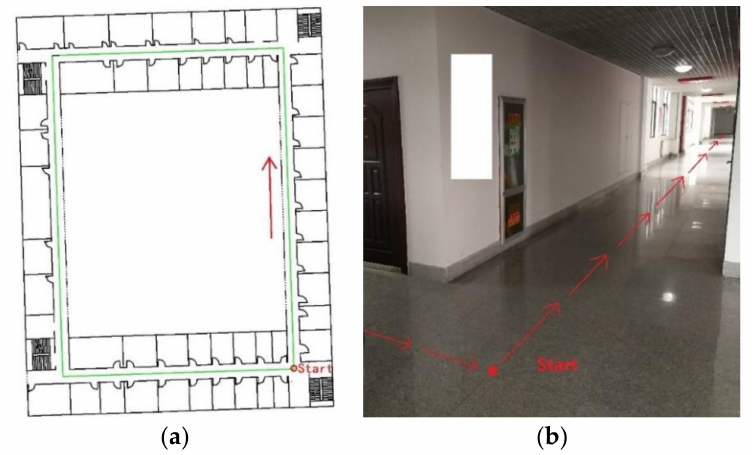
Figure 3. Trajectory of experiment: ( a ) Floor plan; ( b ) Experimental